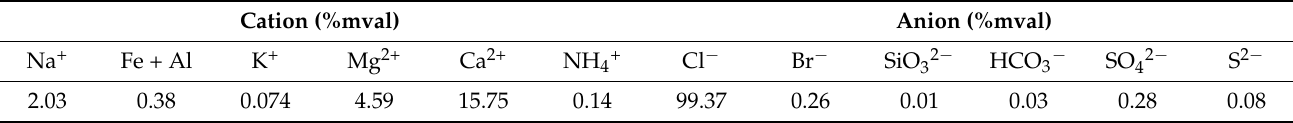
Table 1. Average ionic composition of the reservoir